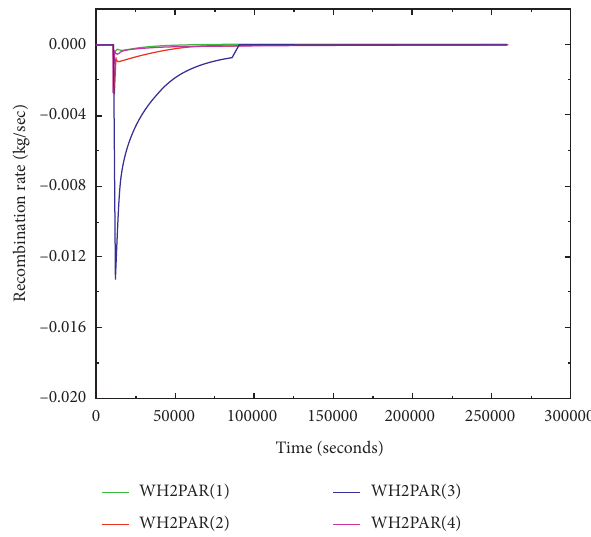
Figure 21: Recombination rate of PARs in each compartment. Table 20: Peak value of hydrogen mole fraction with PAR modeling.